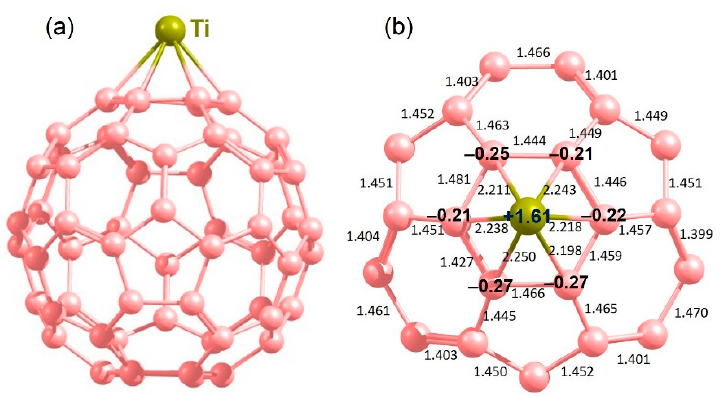
Figure 4. Optimized structure of ( a ) Ti atom adsorbed on the hexagonal ring of C 60 , ( b ) bond lengths (Ti-C and C-C) and Bader charges on the Ti atom and the adjacent C atoms directly bonded to it. The total DOS plot exhibits that the Ti-supported C 60 is metallic (see Figure 5a). This is due to strong perturbation of C 60 with Ti. The atomic DOS plots shows that the Fermi energy level is mainly populated with d states of Ti (see Figure